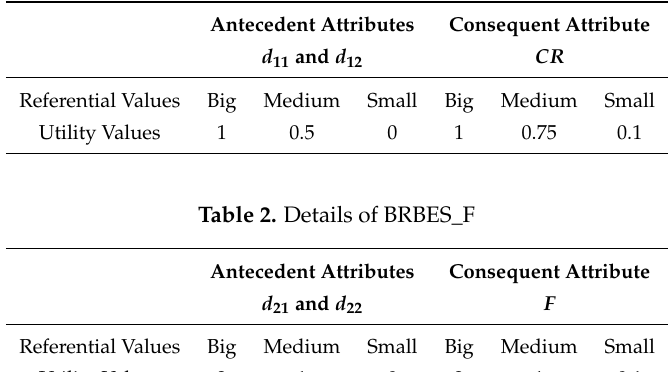
Figure 5. Two BRBESs used for BRBaDE. Table 1. Details of Belief Rule-Based Expert System